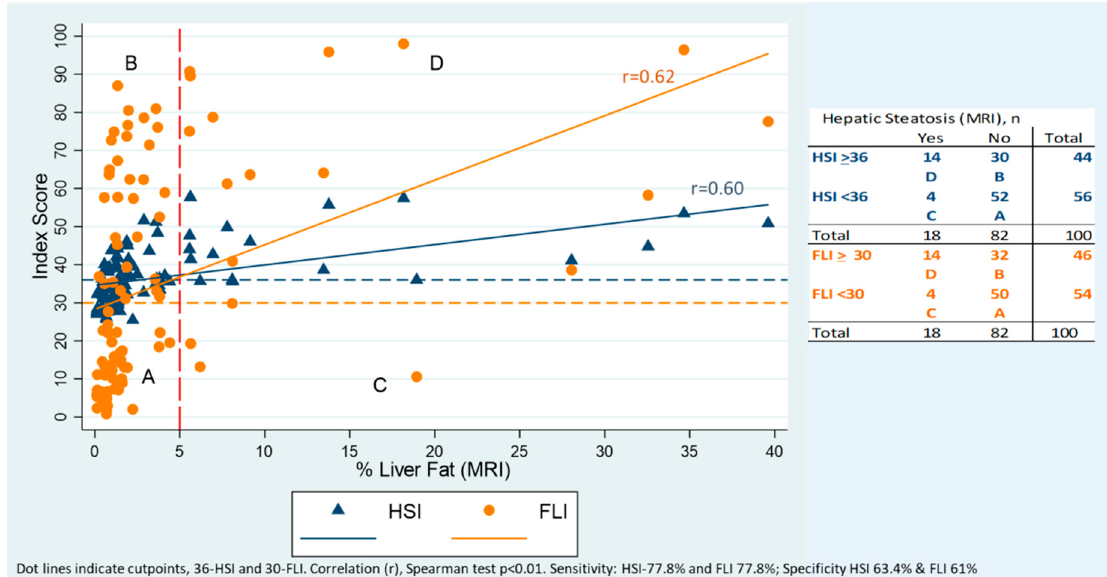
Figure 1. Correlation between the Hepatic Steatosis Index (HSI) and Fatty Liver Index (FLI) with the amount of fat in the liver (%) by